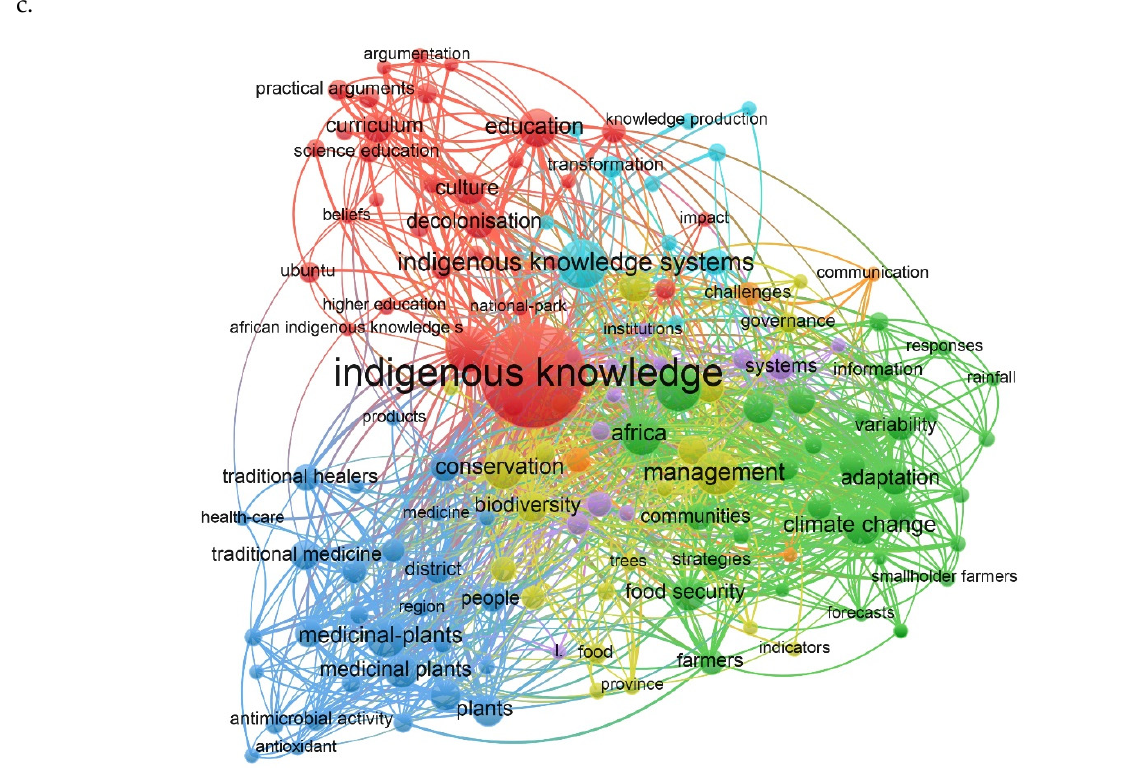
Figure 4. Network visualization map of co-occurring keywords in indigenous knowledge literature— ( a ) global view, ( b ) African view, and ( c ) South African view—published from 1990 to 2020. 3.3. Existing, Current, and Emerging Trend Topics for All Keywords on Indigenous